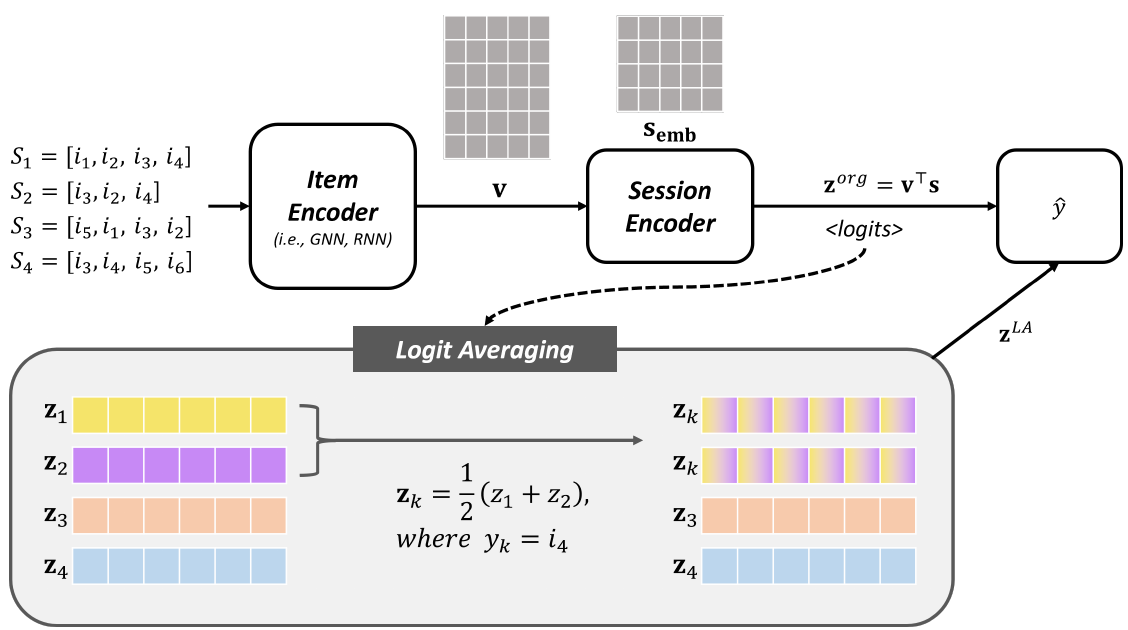
Figure 1. General deep-learning-based session-based recommendation models framework with the proposed